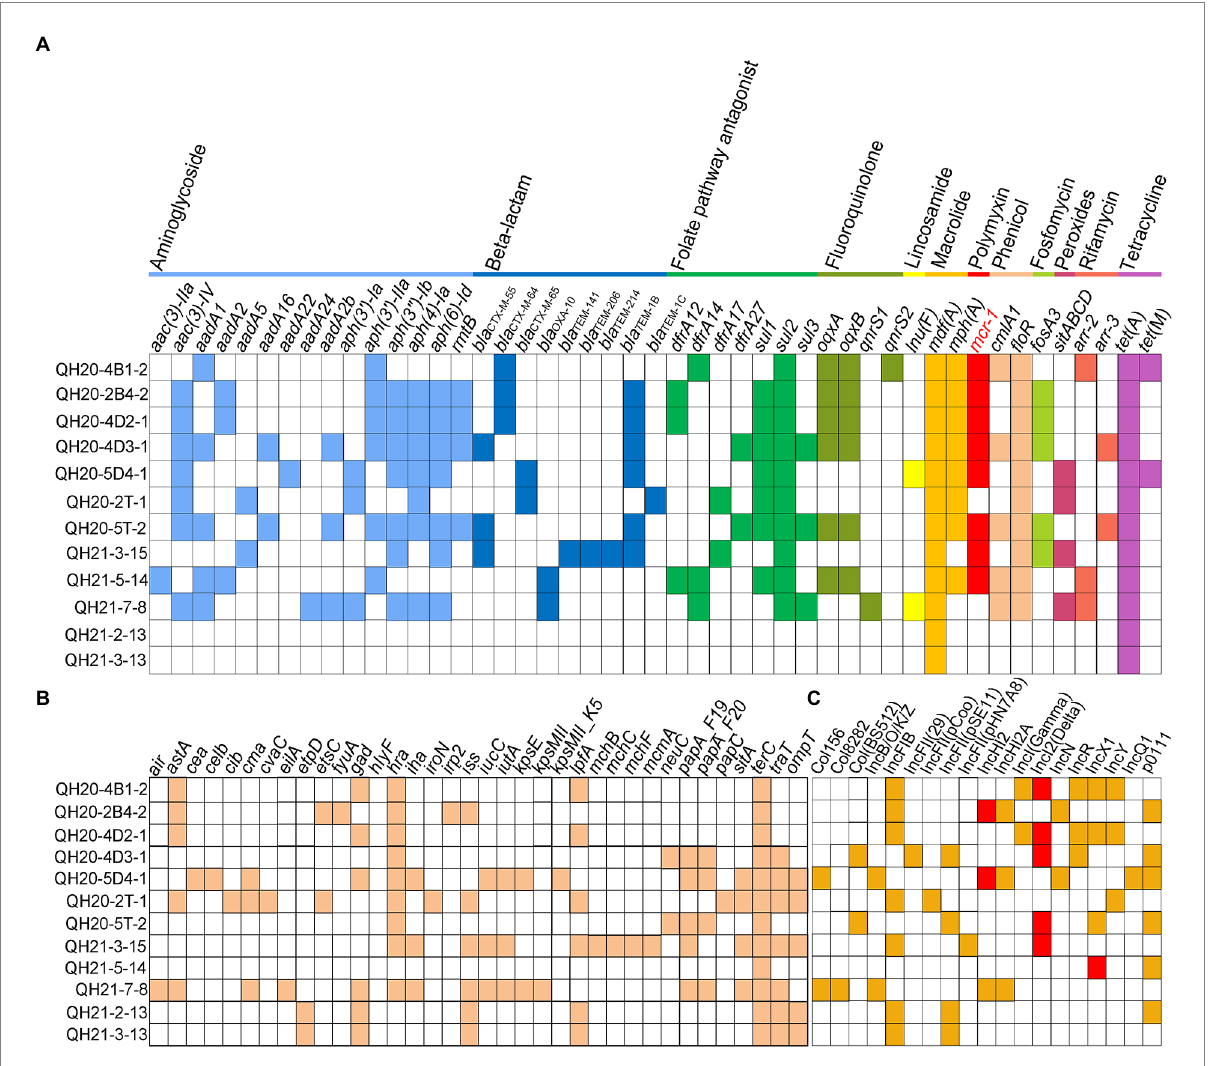
FIGURE 4 Acquired resistance genes, virulence genes, and plasmid replicon types of Escherichia coli strains with whole-genome sequences. (A) Antimicrobial resistance (AMR) gene profiles. Various types of AMR genes are labeled with different colors. White squares indicate no